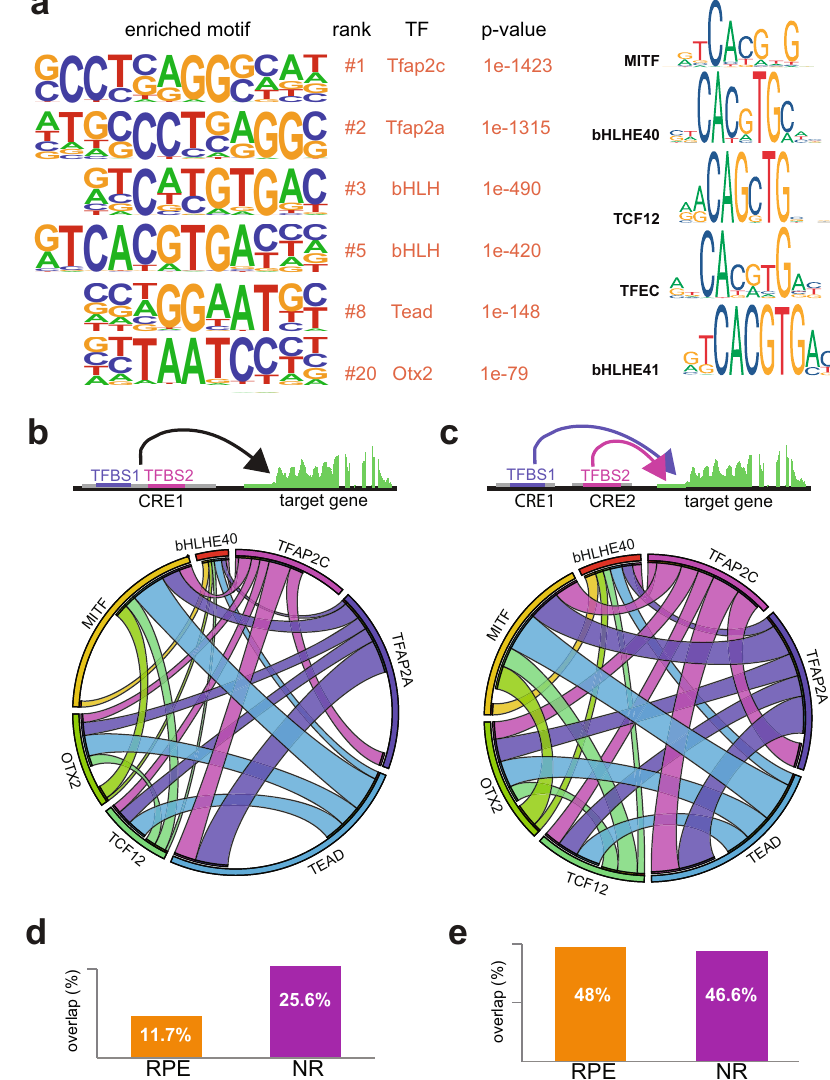
Fig. 5 RPE motif enrichment analysis. a Representative TF binding motifs enriched in RPE DOCRs as identi fi ed by HOMER. Analysis of the binding motif similarity among TFs of the bHLH family (http://jaspar.genereg.net). b Circoplot illustrating the co-occupancy rate of TFBS in the same DOCRs for the main TFs identi fi ed in the motif enrichment analysis. c Circoplot illustrating the degree of co-regulation between TFs regulating the same gene through different DOCRs. d Average percentage of co-occupancy in the same DOCR for two different TF in the RPE and NR. e Average percentage of two different TF regulating the same gene through different DOCRs in the RPE and